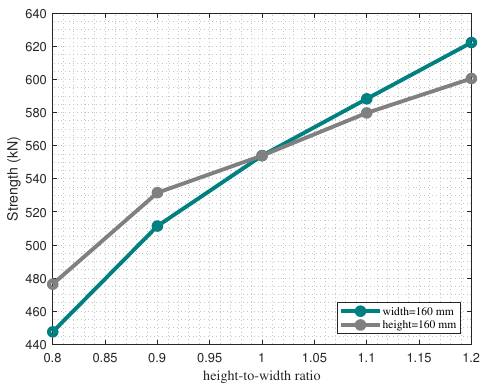
Figure 9. Shear wall strength S for different h / w